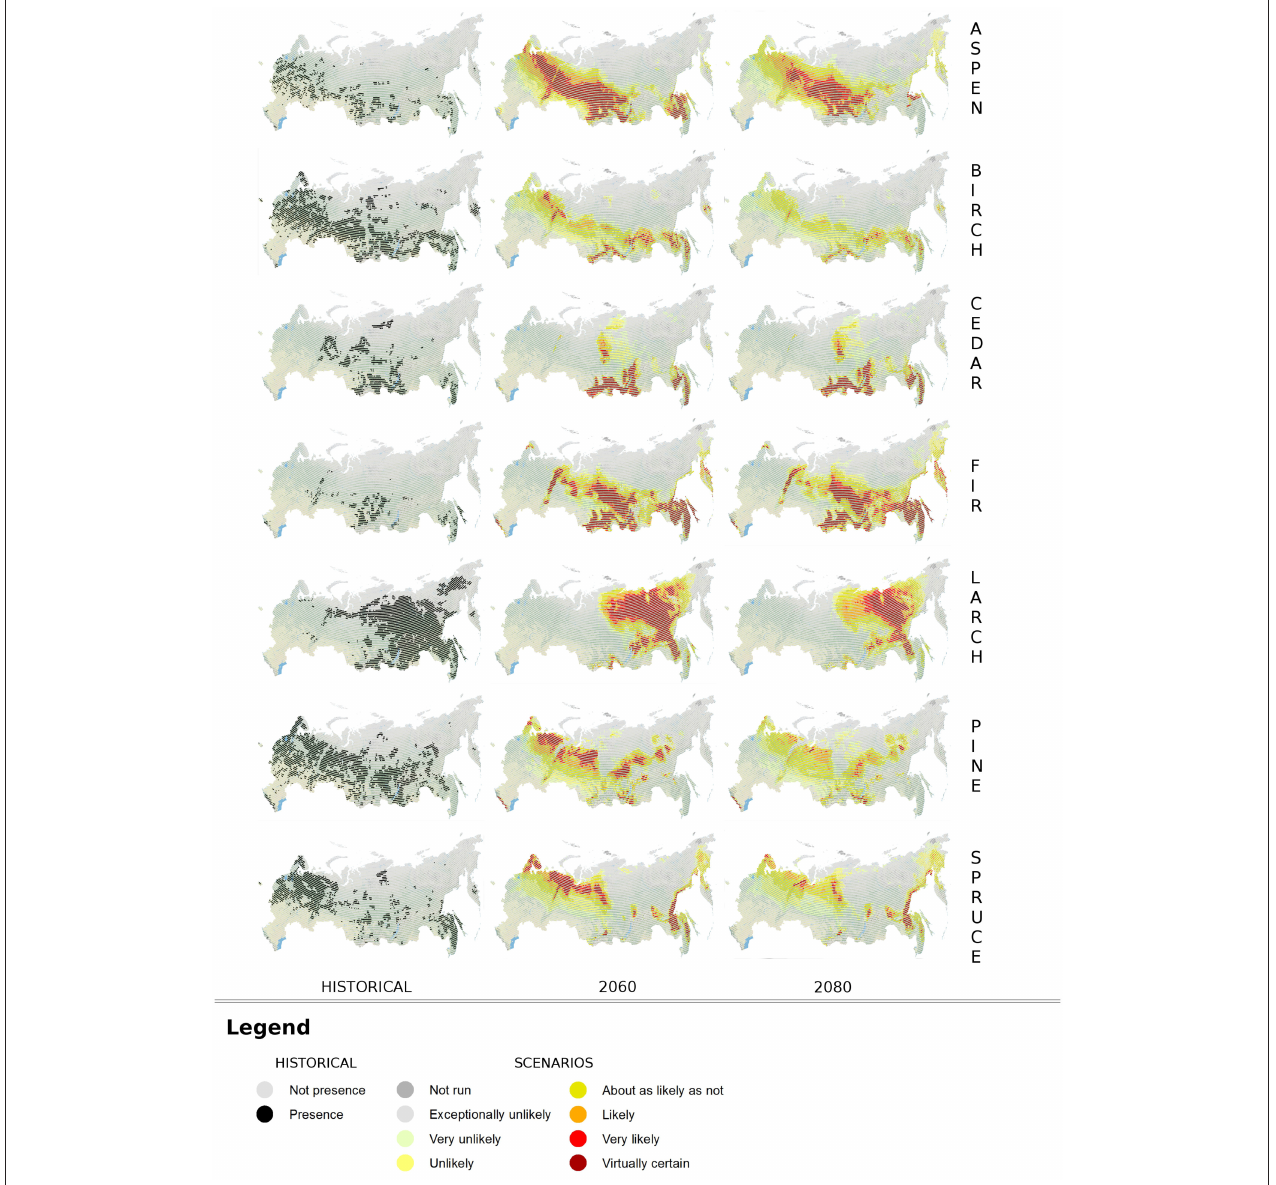
FIGURE 4 | Output maps from the Cascade Ensemble System (CES). Forest species distribution according to historical period (presence-not presence; left side) and future scenarios for 2060 (central column) and 2080 (right side), with likelihood